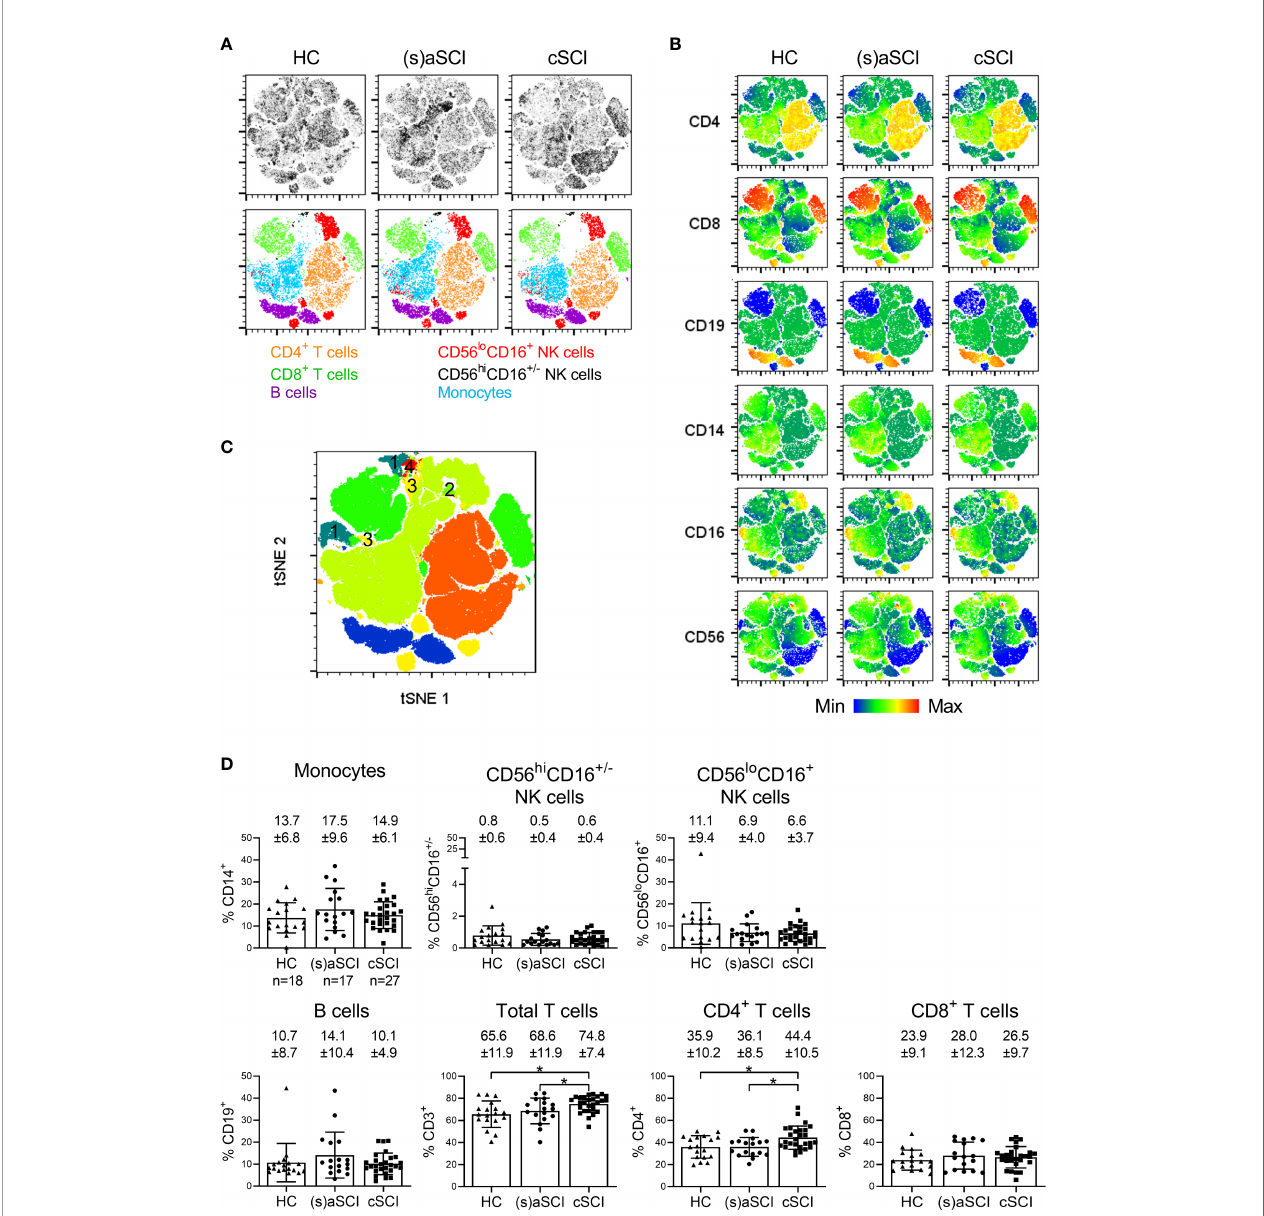
FIGURE 1 | Frequency of general immune cell subsets in the peripheral blood of HC and SCI patients. (A) tSNE maps showing the major immune cell subsets within single cells of HC (n = 18) and SCI patients (n = 18), including (s)aSCI (17 samples) and cSCI (27 samples). In the upper row, tSNE maps are shown on a density plot while the lower row shows the manually determined gates on the tSNE maps. (B) Surface marker distribution is depicted in the tSNE map. Relative antigen expression is visualized by the color tone (from blue to red). (C) FlowSOM clusters are shown in the tSNE map as overlay. The clusters that were not included in our manual gating strategy are numbered from 1 to 4. (D) Percentages of monocytes, CD56 hi CD16 +/- NK cells, CD56 lo CD16 + NK cells, B cells, total CD3 + T cells, CD4 + T cells and CD8 + T cells are shown within the lymphocyte population. Mean (bars) ± SD is depicted and shown in numbers. The number of included samples in each group is shown in the fi rst graph. *p <